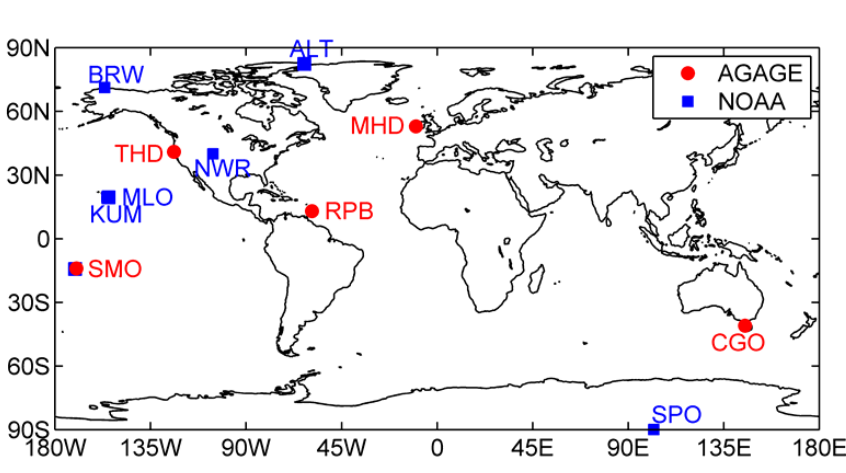
Fig. 1. Location of CCl 4 observing sites used in the inversions (see Table 1 for station abbreviations and